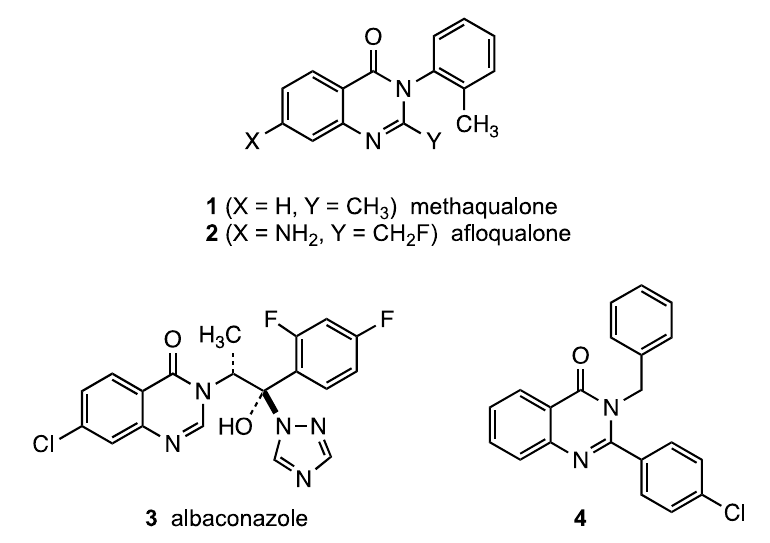
Figure 1. Bioactive quinazolin-4(3 H )-ones.